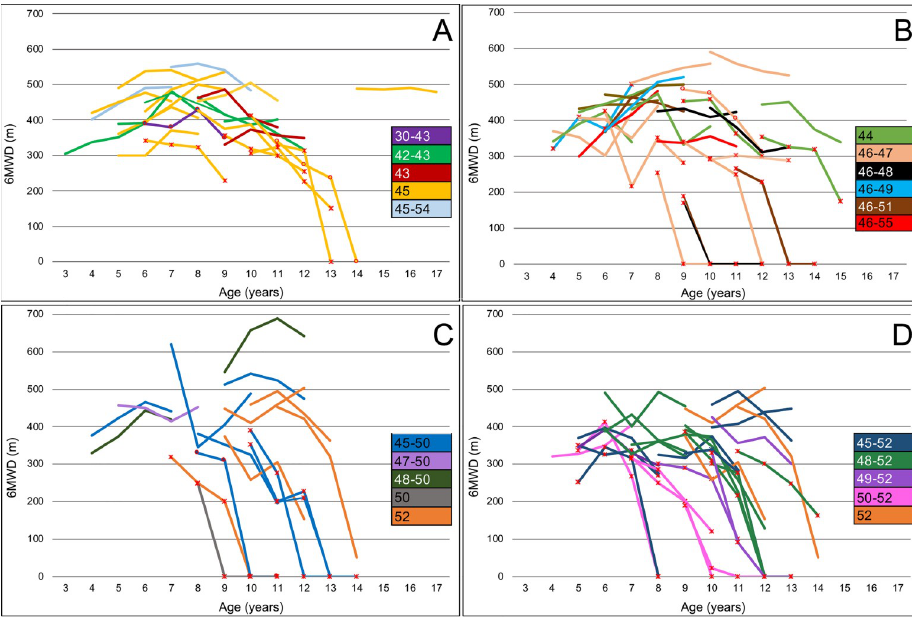
Fig 2. Individual 6MWT changes with details of the mutations within skipping subgroups. Panel A: Cohort skipping exon 44. Panel B: Cohort skipping exon 45. Panel C: Cohort skipping exon 51. Panel D: Cohort skipping exon 53. ✳ = TRF � 6 sec, � = TRF not